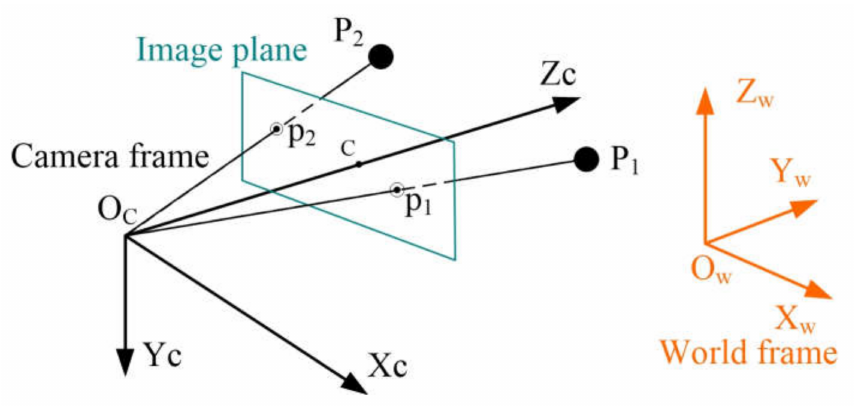
Figure 1. Standard pinhole camera model with two 3D control points. Here C is the principal